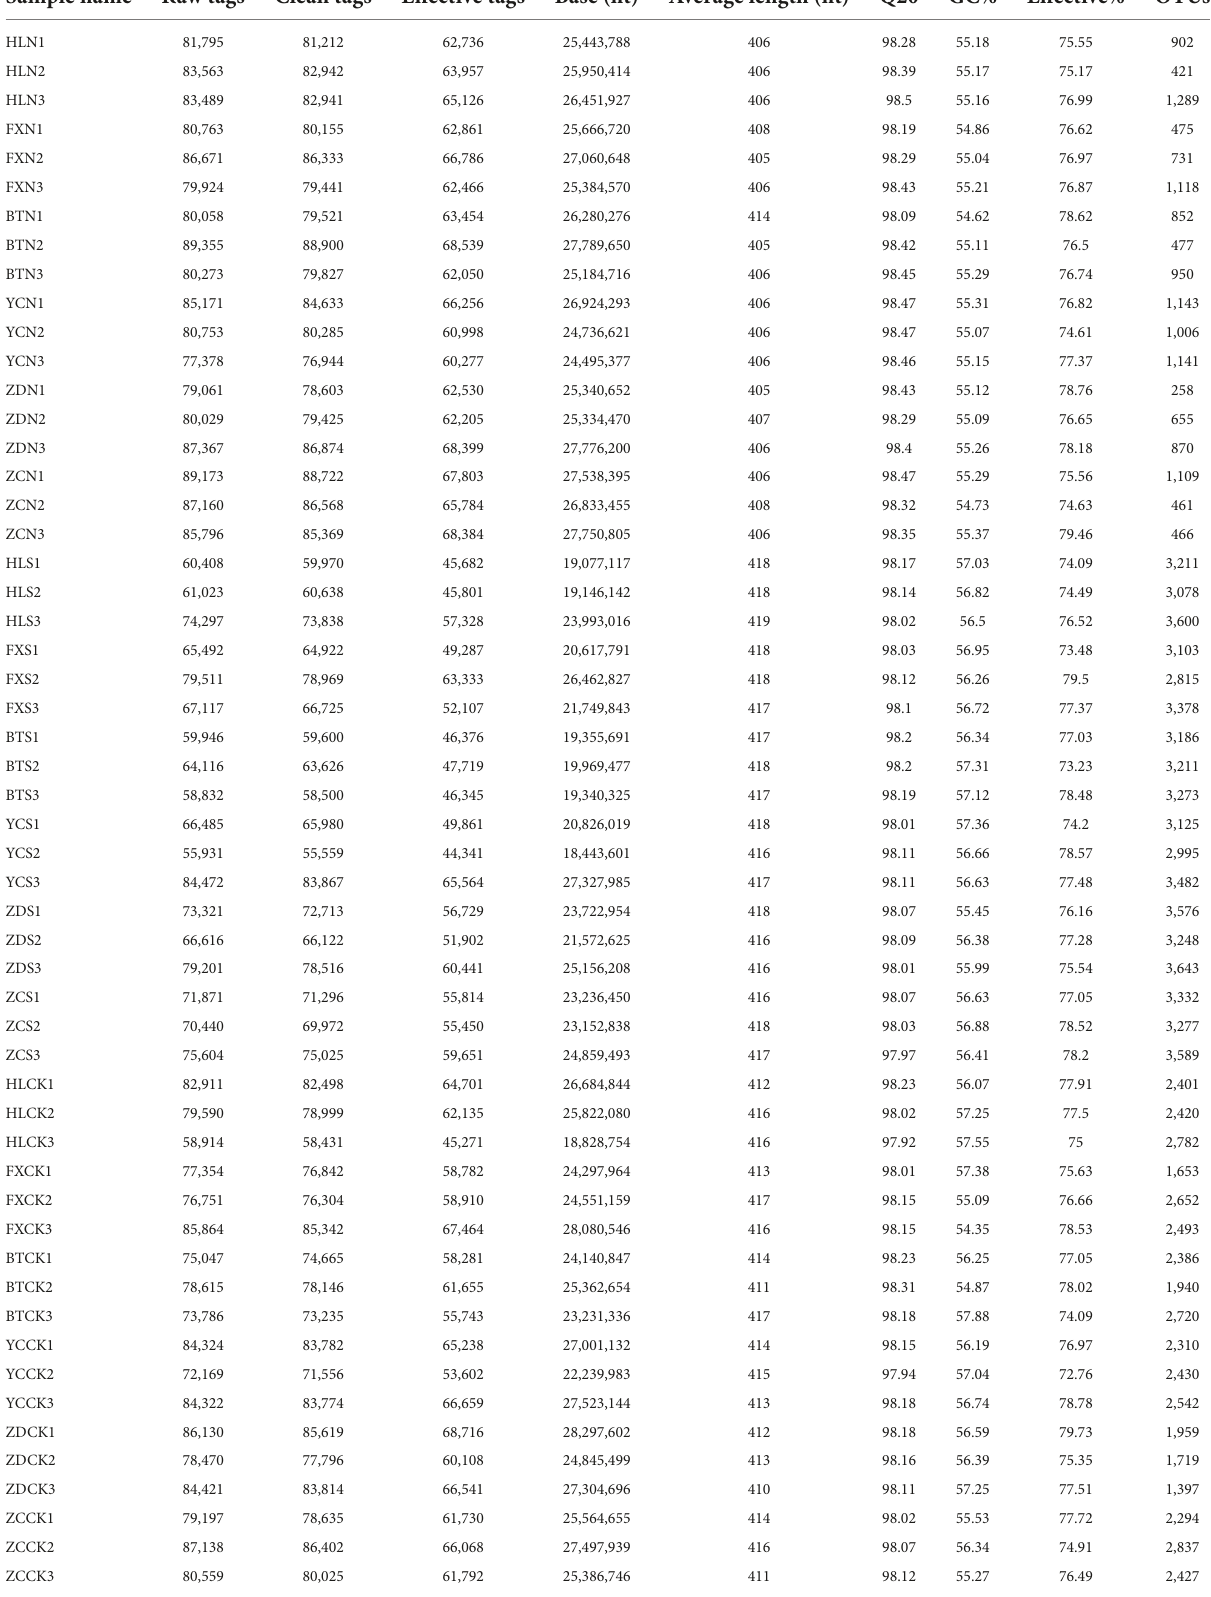
TABLE 2 Quantitative statistics of bacterial OTUs and tags of each